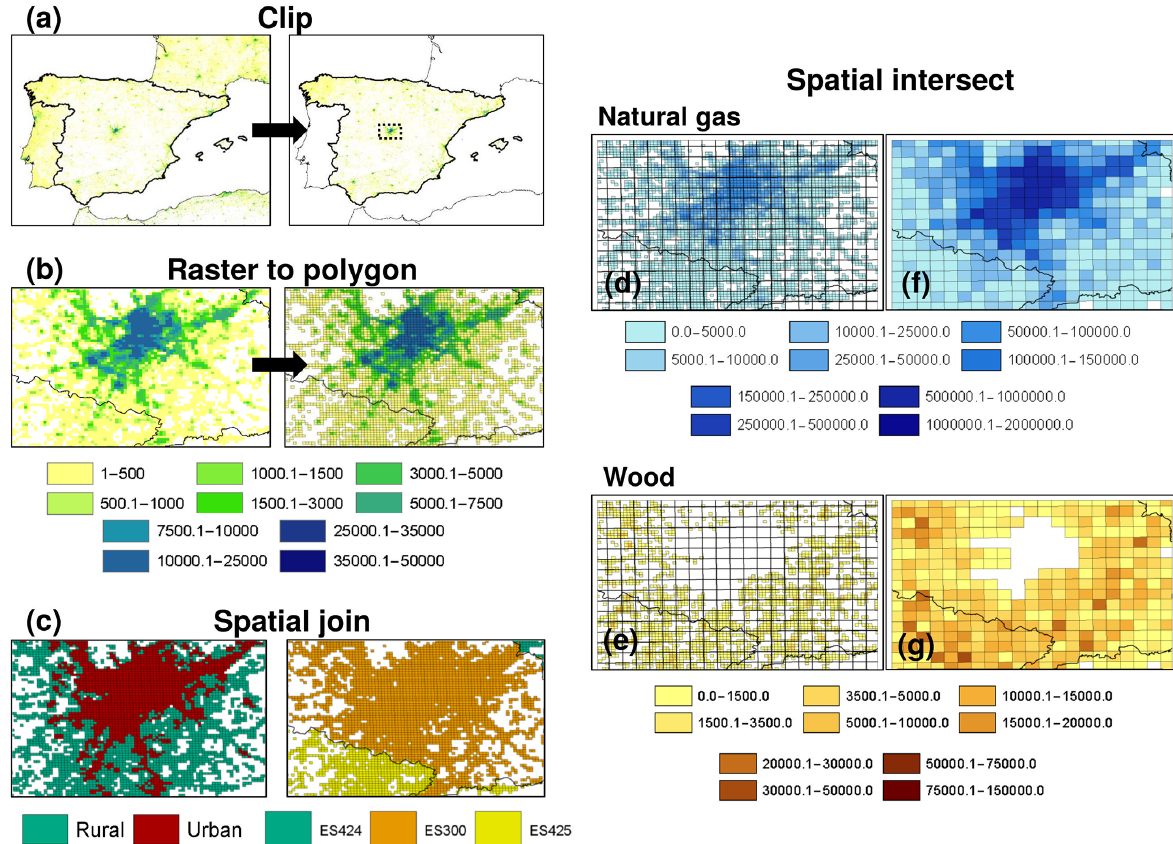
Figure 3. Examples of the spatial operations performed by HERMESv3_BU during the initialization of the residential and commercial combustion emission sector, including (a) a clip of the original GHSL population density raster (population per pixel) using a shapefile of the administrative borders of Spain, (b) a conversion of the clipped raster to a polygon feature (population per cell) (zoom over the area of Madrid), (c) the spatial joins performed to append the NUTS3 administrative boundary codes (ES300, Madrid; ES424, Guadalajara and ES425, Toledo) and the GHSL settlement categories (urban, rural) to each source grid cell, and the spatial intersections applied to remap the fuel consumption data (natural gas in urban and rural areas and wood in rural areas) (GJper cell per year) from the source (d, f) domain to the user-defined (e, g) destination domain (4km by 4km Lambert conformal conic